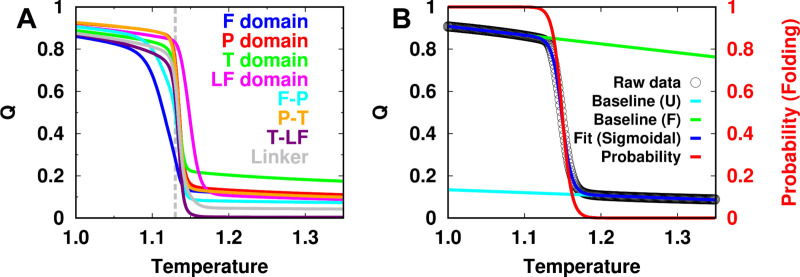
Melting curve of each domain/interface and two-state sigmoidal fitting.(A) Melting curves of Q for each intradomain, interdomain, and linker of DPO4 for ρ0. The dashed line indicates the folding temperature. (B) One example of a melting curve of the P domain of DPO4 and its fitting to the two-state sigmoidal transition to obtain the folding probability curve PI⁢(T), where I is the index of the intra- or interdomain and T is the temperature. The data for the P domain shown here are chosen for the purposes of illustration. Similar results can be observed for the other intra- and interdomains for different values of ρ. The fitting procedure follows the standard protocol instructed by Sborgi et al., 2012.